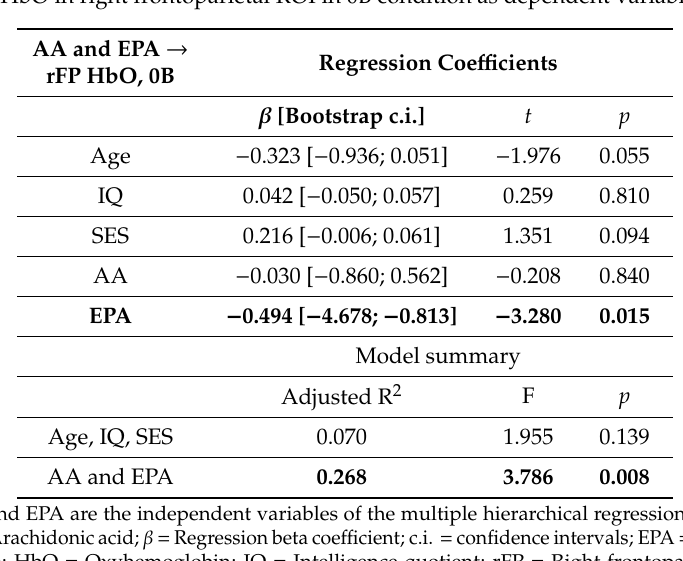
Table 3. Multiple hierarchical regression results with arachidonic acid (AA) and eicosapentaenoic acid (EPA) as independent variables, age, socioeconomic status (SES) and intelligence quotient (IQ) as covariates, and HbO in right frontoparietal ROI in 0B condition as dependent variable. AA and EPA → Regression Coe ffi cients rFP HbO, 0B β [Bootstrap c.i.] t p Age − 0.323 [ − 0.936; 0.051] − 1.976 0.055 IQ 0.042 [ − 0.050; 0.057]